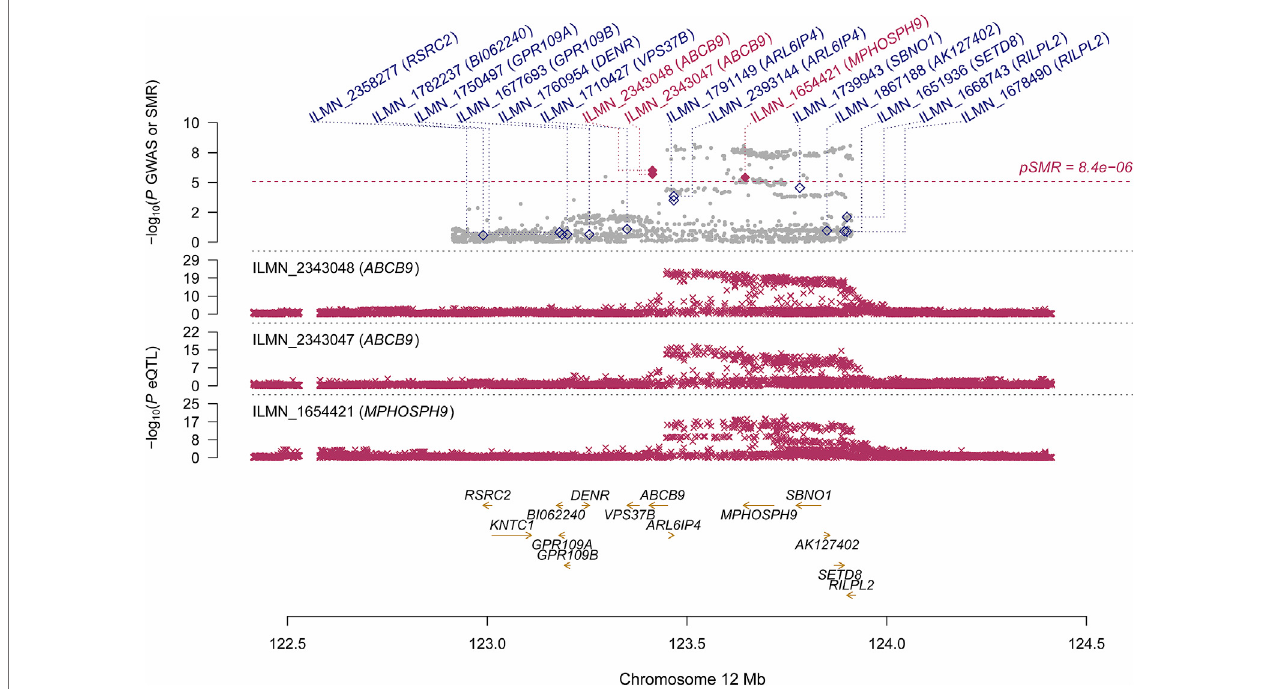
FIGURE 3 | Pleiotropic association of ABCB9 and MPHOSPH9 with ULs using CAGE eQTL data. Top plot, grey dots represent the log10(p values) for SNPs from the GWASofULs,withsolidrhombusesindicatingthattheprobespassHEIDItest.Middleplot,eQTLresults.Bottomplot,locationofgenestaggedbytheprobes.CAGE,Consortium for the Architecture of Gene Expression; eQTL, expression quantitative trait loci; GWAS, genome--wide association studies; GTEx, Genotype--Tissue Expression; HEIDI, heterogeneity in dependent instruments; SMR, summary data--based Mendelian randomization; SNP, single nucleotide polymorphism; ULs, uterine leiomyomas.